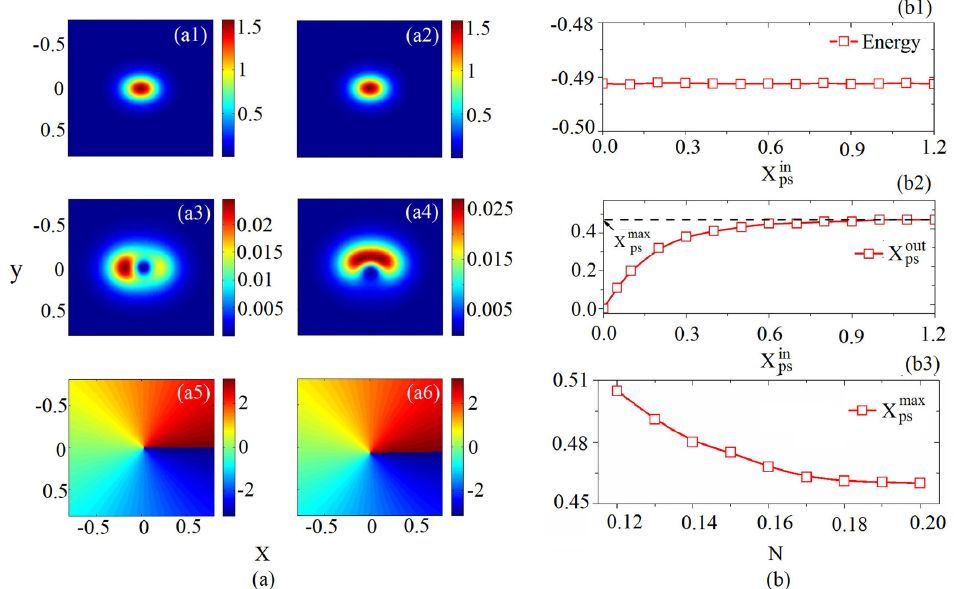
Figure 2. Stable asymmetric vortex solitons (AVS) numerically obtained from Equation (4). ( a ) Stable AVS with total norm N = 0.15. The first column presents the density distribution of the fundamental and vortical component, | φ + ) | 2 and | φ − | 2 , and the phase structure of φ − , with ( X ps , Y ps ) = ( 0.04,0 ) . The second column is the AVS with ( X ps , Y ps ) = ( 0,0.065 ) . ( b ) Various relations between the input and output X ps with energy and the total norm of the AVS